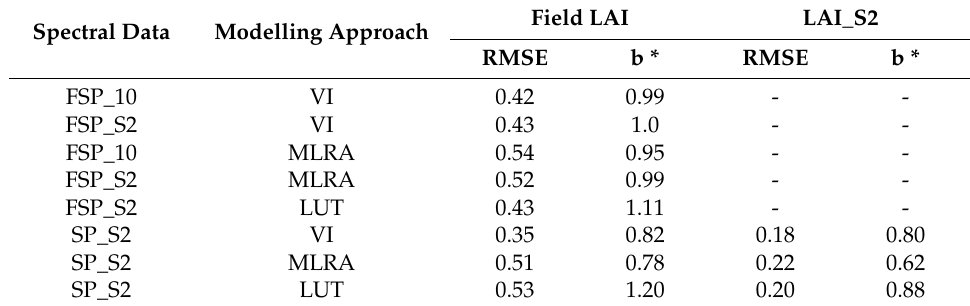
Table 9. Multi-comparison of LAI measured and estimated based on different combinations of modelling approaches and remote sensing validation data-set. Spectral